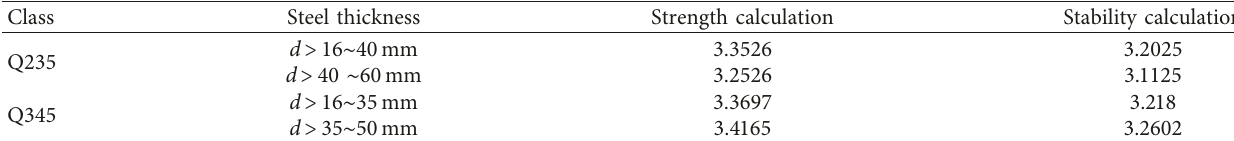
Table 9: Summary of reliability calibration results of transmission tower.